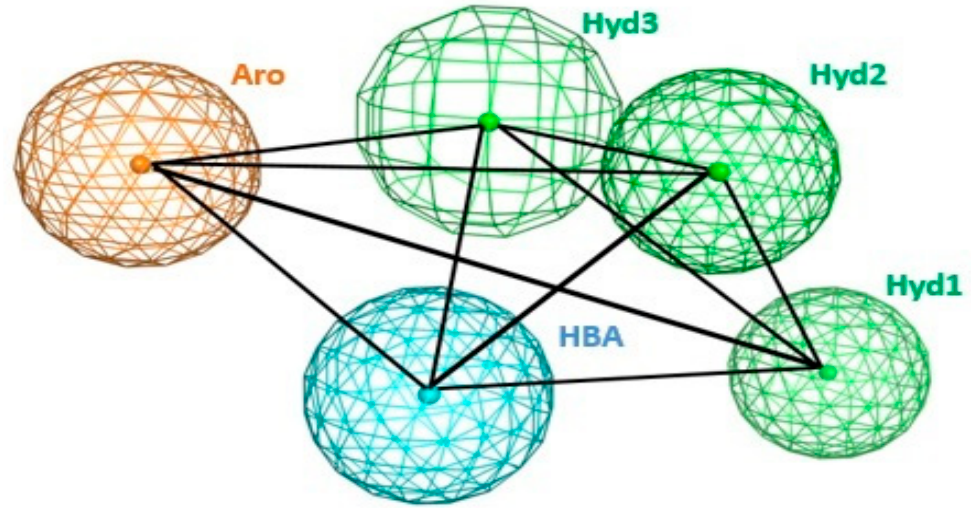
Figure 1. Pharmacophore model with three hydrophobic, one hydrogen bond acceptor, and one